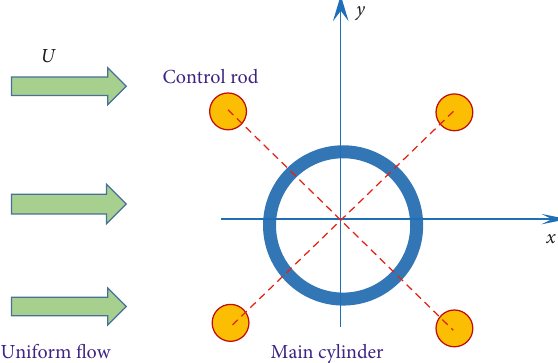
Figure 1: Schematic diagram of the main cylinder with 4 control rods.